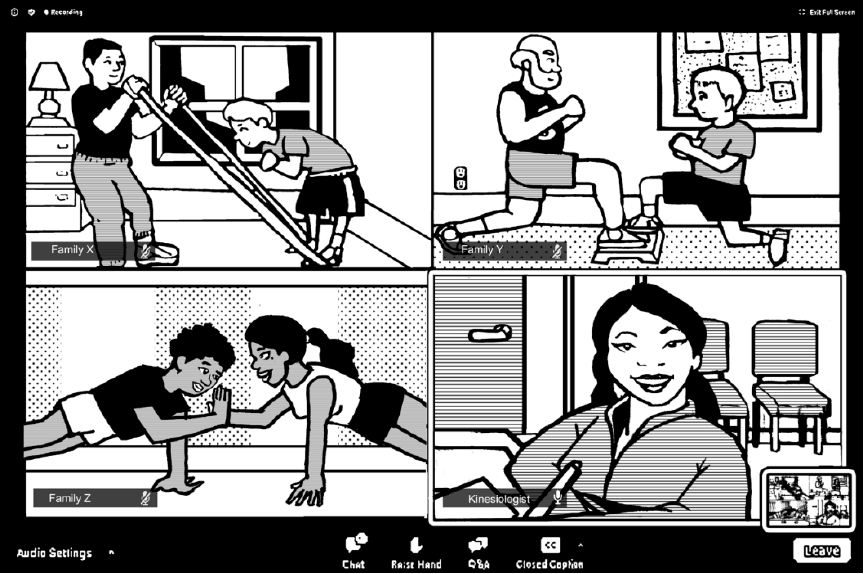
Figure 1. Illustration of videoconferencing interface during a group session, by Nizar Laarais.